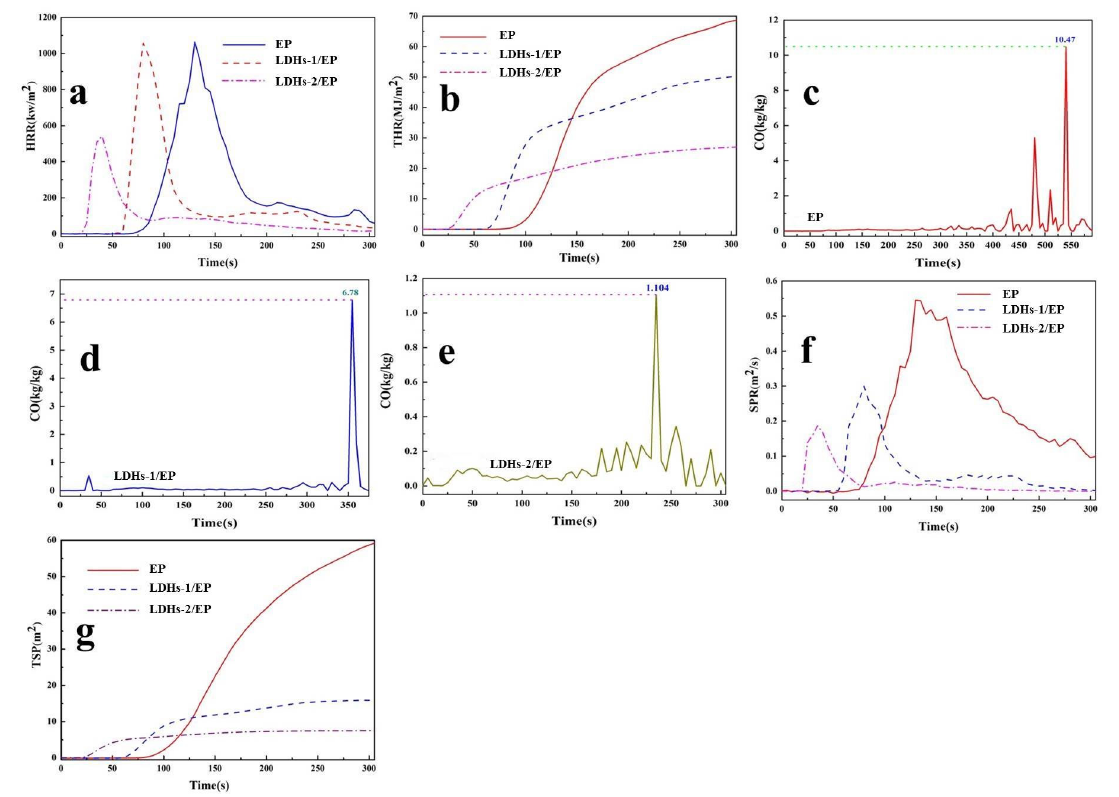
Figure 7. ( a ) HRR, ( b ) THR, ( f ) SPR, ( g ) TSP curves of EP, LDHs-1/EP and LDHs-2/EP; CO release rate curves of ( c ) EP, ( d ) LDHs-1/EP and ( e ) LDHs-2/EP.